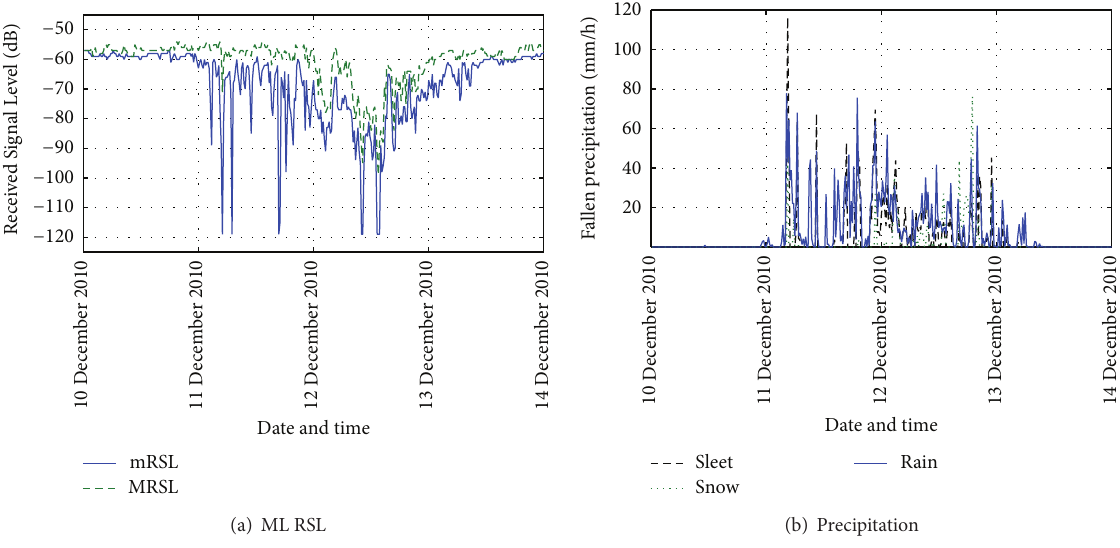
Figure 2: An example of mRSL and MRSL data series, sampled at 15min intervals, with 1dB quantization error (a), and the actual measured fallen precipitation divided into rain, snow, and sleet, as detected by the OTT Parsivel Disdrometer Weather Sensor (b).